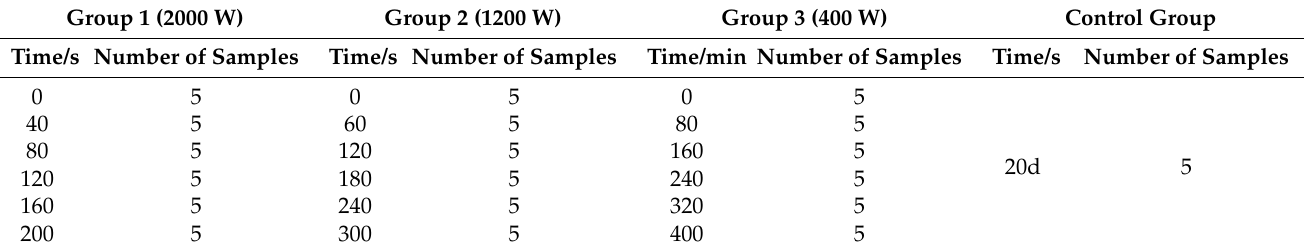
Table 2. Testing scheme to investigate the influence of microwave curing conditions on analog materials.